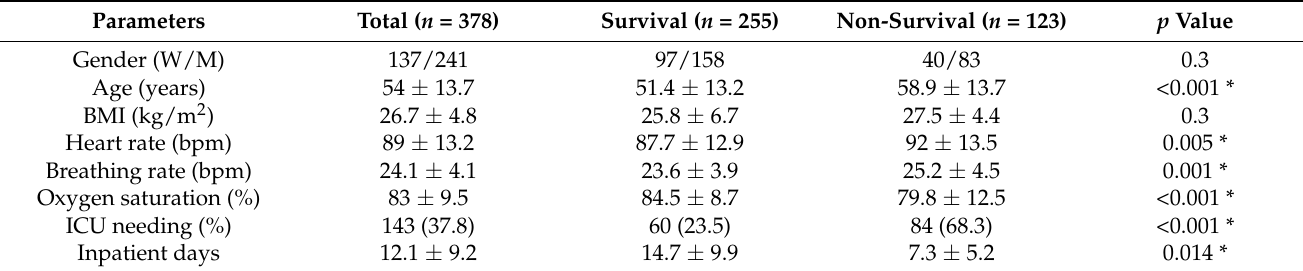
Table 1. Demographic and clinical characteristics of patients enrolled in the study. Data are expressed as media ± standard deviation or absolute values and percentages. * Differences were considered significant when p < 0.05. We only show clinical data that significantly differed between groups. W, women; M, men; BMI, body mass index; T2D, type 2 diabetes; ICU, intensive care unit.